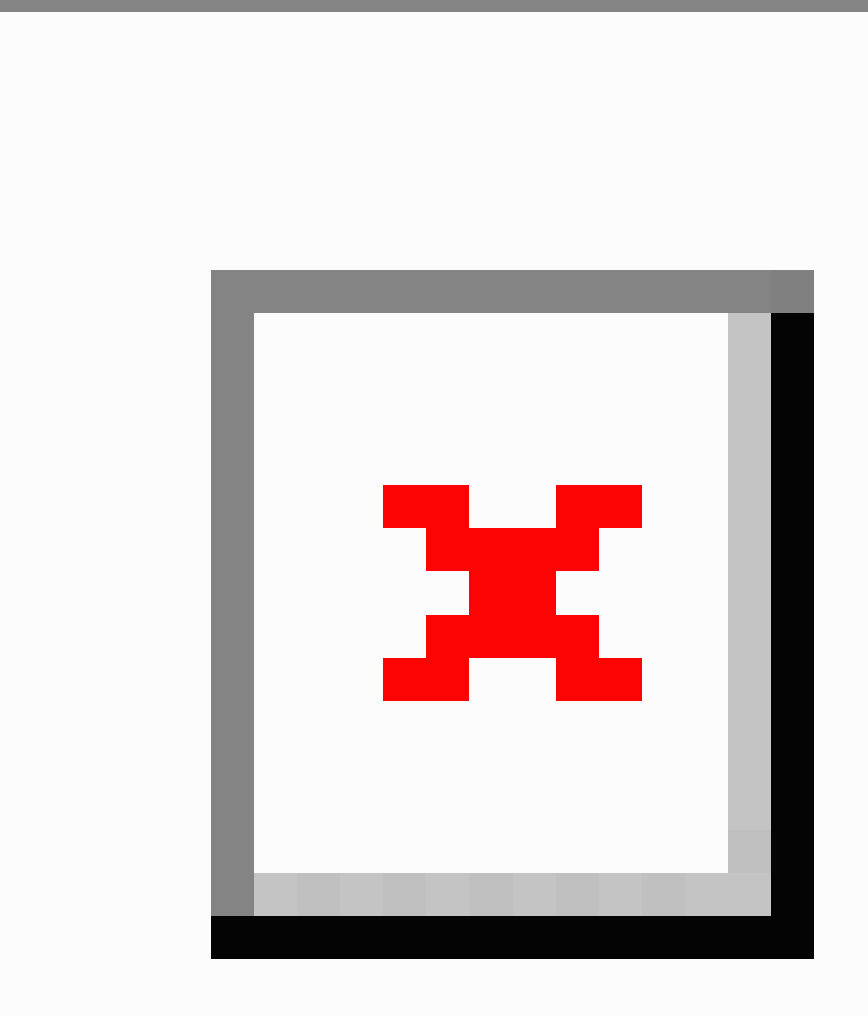
Figure 2. Flow of participants into the historical control